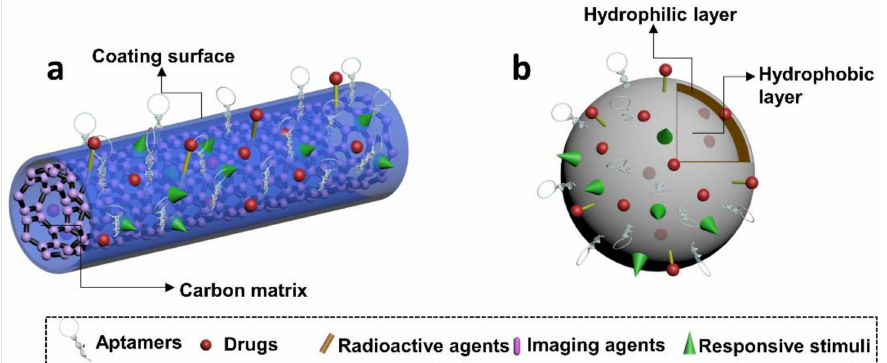
Figure 11. Schematic illustration of aptamer-functionalized carbon and liposome nanomaterials. ( a , b ) are aptamer-decorated versatile carbon and liposome nanomaterials,